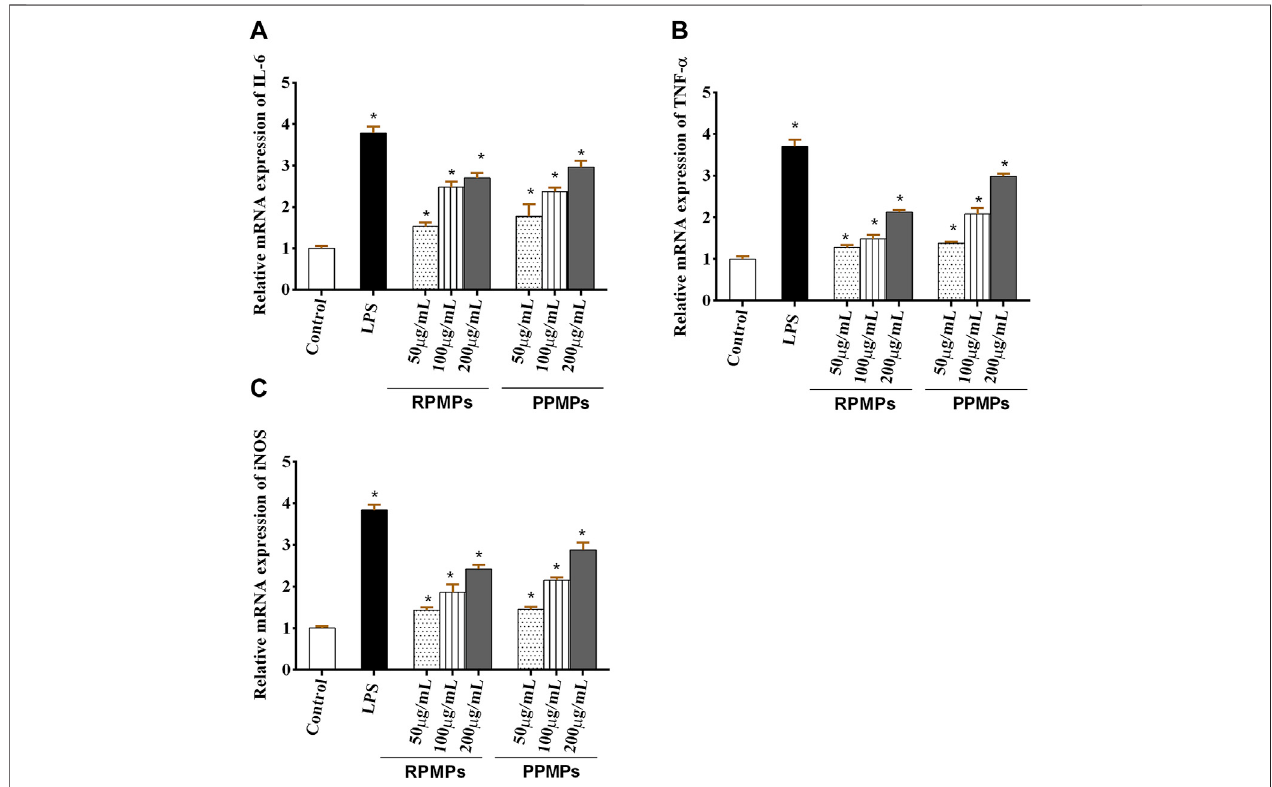
FIGURE7| EffectsofRPMPsandPPMPsonthemRNAexpression ofIL-6 (A) ,TNF- α (B) ,andiNOS (C) inRAW264.7cells.* p < 0.05versusthecontrol.Thedata are presented as mean ± SD ( n = 3).